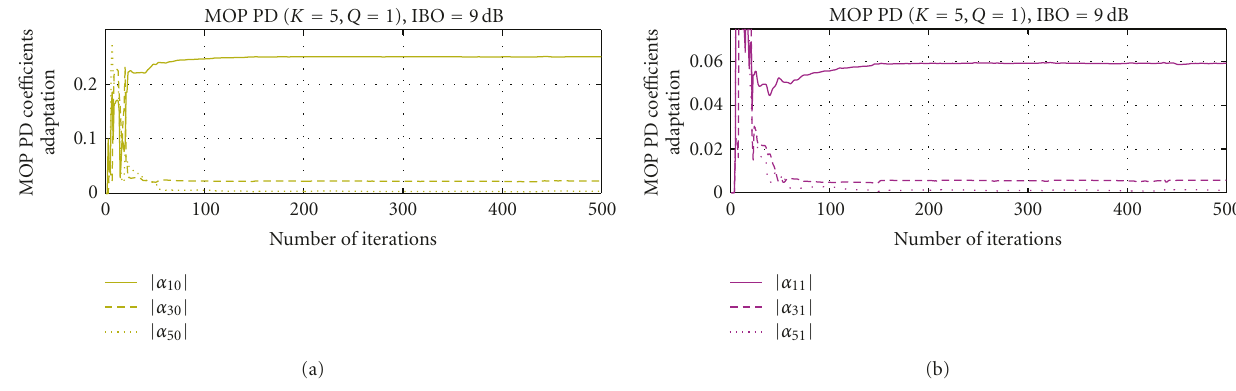
Figure 11: Convergence behavior of the MOP PD coe ffi cients